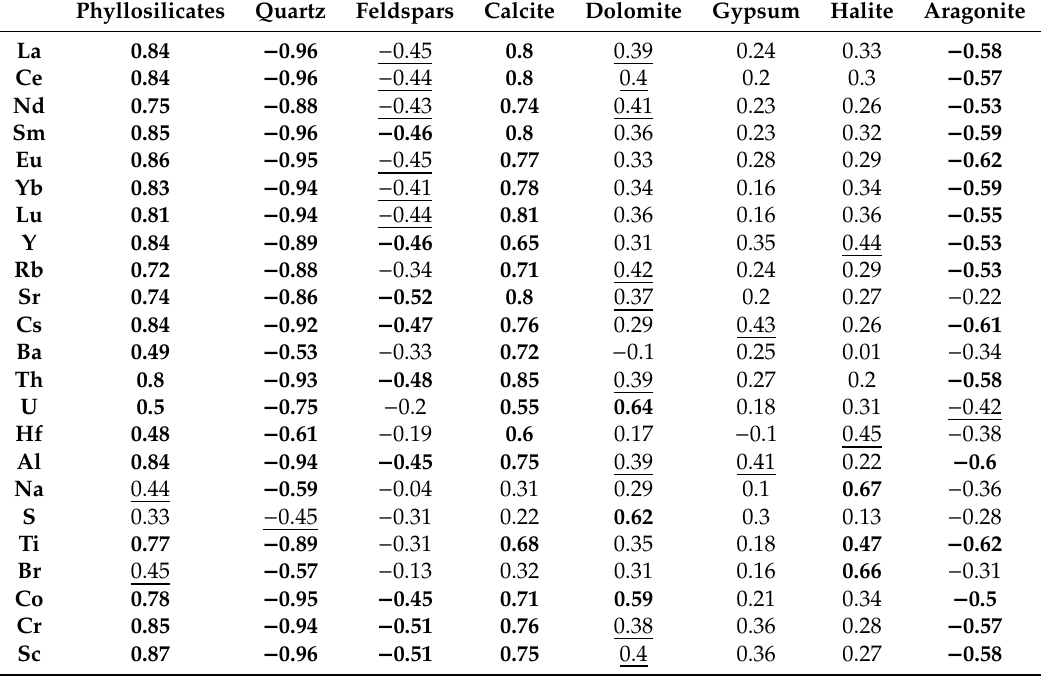
Table 7. Correlation matrix between mineralogy and trace elements. Bold: p < 0.01; underlined: p <